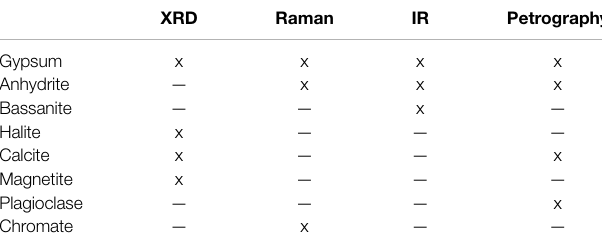
TABLE 1 | Mineralogical detections by different methods.